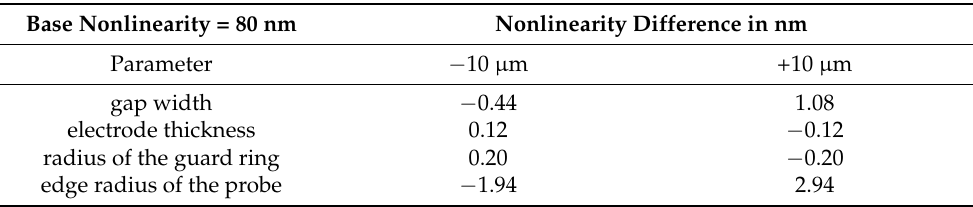
Table 2. Changes in the nonlinearity depending on the sensor parameters for a given manufacturing tolerance of ± 10 µ